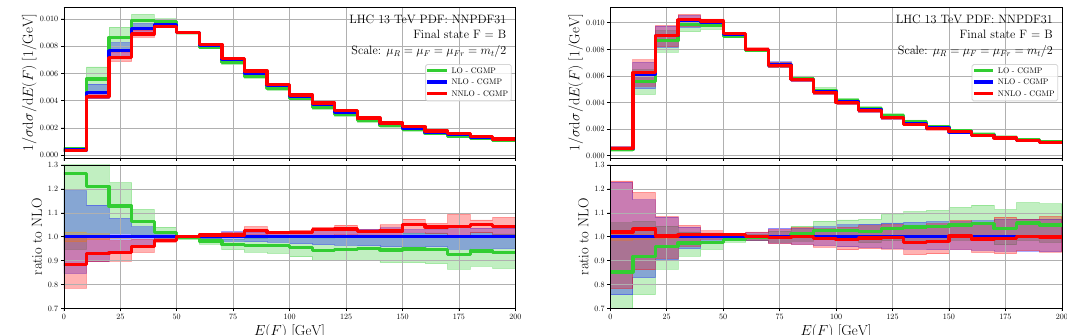
Figure 12 . The normalized E ( B ) distribution for fixed scale (3.2). Shown are the 15 point scale variation bands for LO, NLO and NNLO as well as the NPFF r.m.s. uncertainty band. The plot to the right is like the one to the left but with LO top